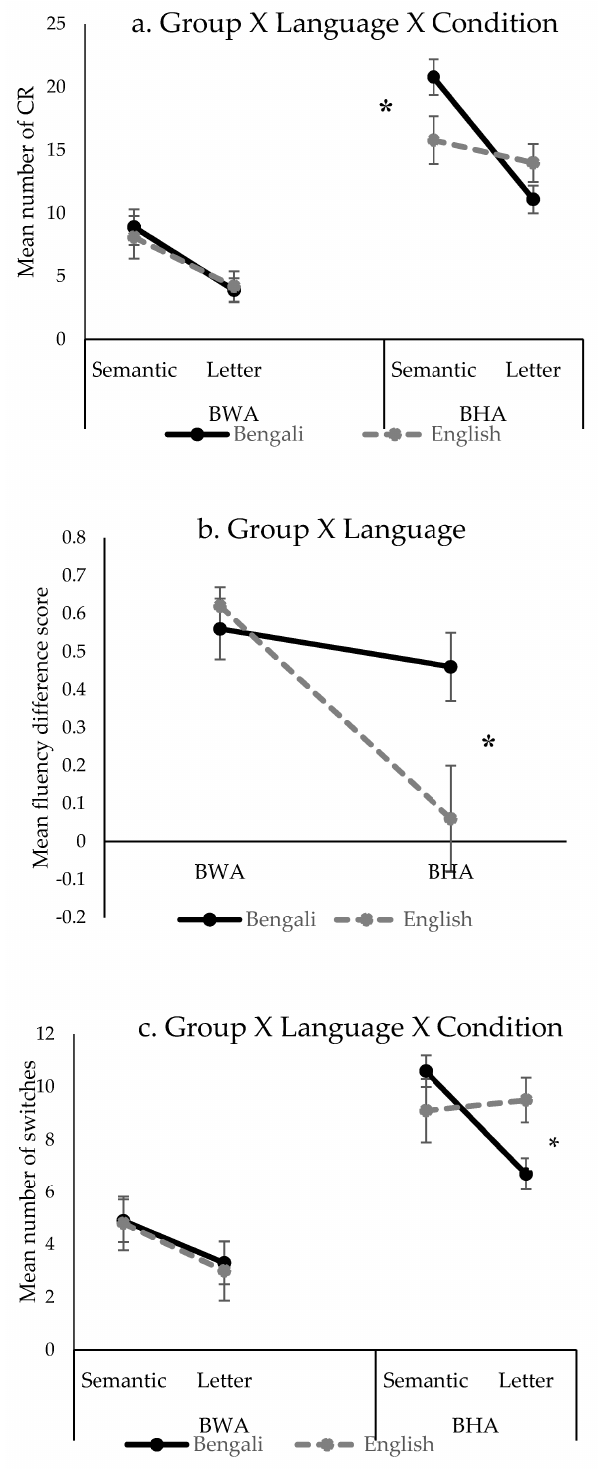
Figure 1. Verbal fluency variables which revealed significant three-way and two-way interactions: ( a ) Mean number of correct responses (CR) (top panel); ( b ) Mean fluency di ff erence score (middle panel); ( c ) Mean number of switches (lower panel). Error bars represent standard error of the means. BWA: Bilinguals with Aphasia: BHC: Bilingual Healthy Controls. *—represents significant di ff erence (p <